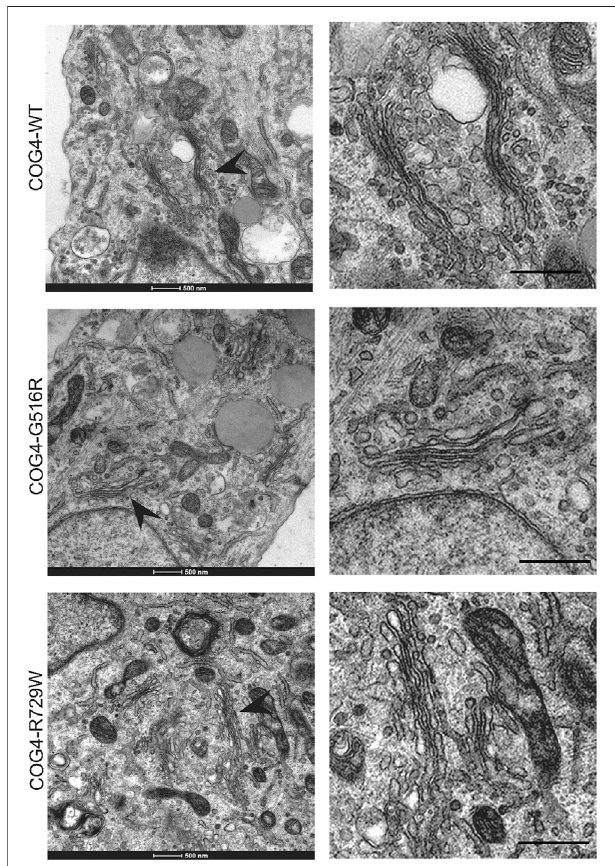
FIGURE 4 | Golgi ultrastructure is not perturbed in cells expressing COG4 mutants. Transmission Electron Microscopy has been performed to see the detailed ultrastructure of rescued RPE1 COG4-WT-3myc, COG4- G516R-3myc, and COG4-R729W-3myc cell lines. Black arrowhead indicates the Golgi. On the right side, the zoom view of the Golgi region is shown. The scale bar is 500 nm.